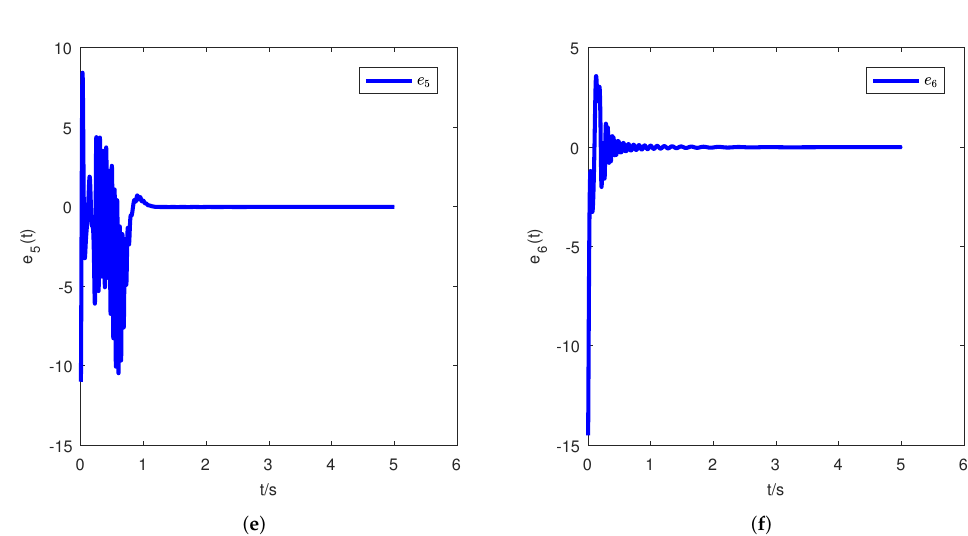
Figure 1. ( a – f ): Error vector between drive system (25) and response system (27).